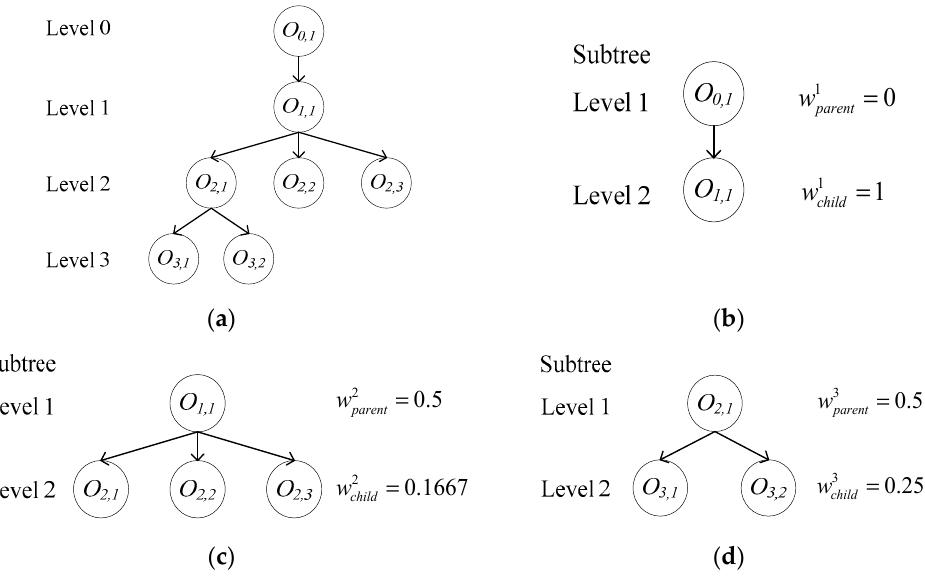
Figure 6. An example illustrating the weighting subtree generation. ( a ) A tree; ( b ) weighting subtree 1; ( c ) weighting subtree 2; ( d ) weighting subtree 3.